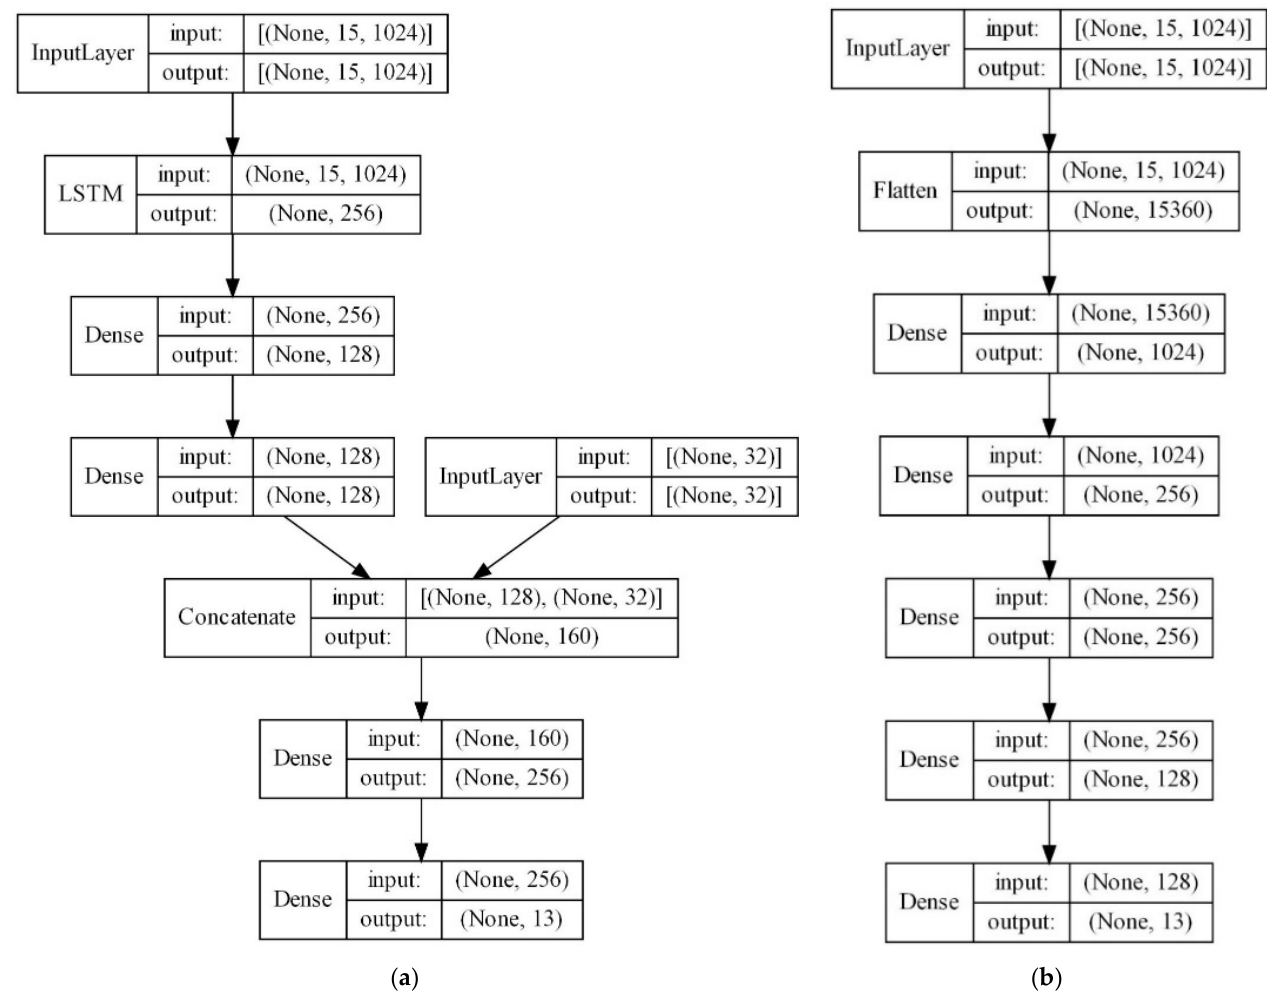
Figure 2. Topologies of the two optimal models that resulted in the highest accuracy (with an additional input for pre-crystallization solvents ( a ) and without the same ( b )).